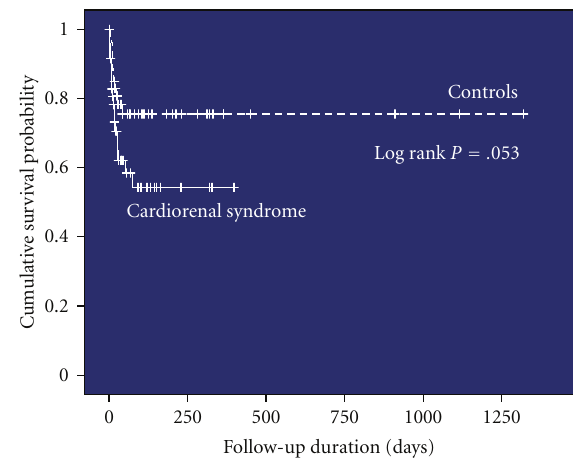
Figure 1: Kaplan-Meier survival curves showing that survival was not significantly higher in controls than in cardiorenal syndrome (75.5% versus 54.3%). Similarly, the survival times were not significantly di ff